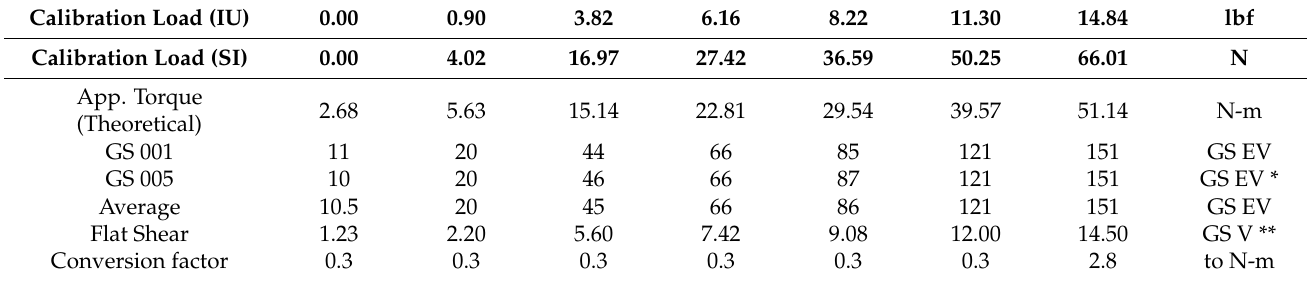
Table A10. The table shows the results from varying torque applied along the Going Stick’s probe tip using the calibration rig. Calibration Load